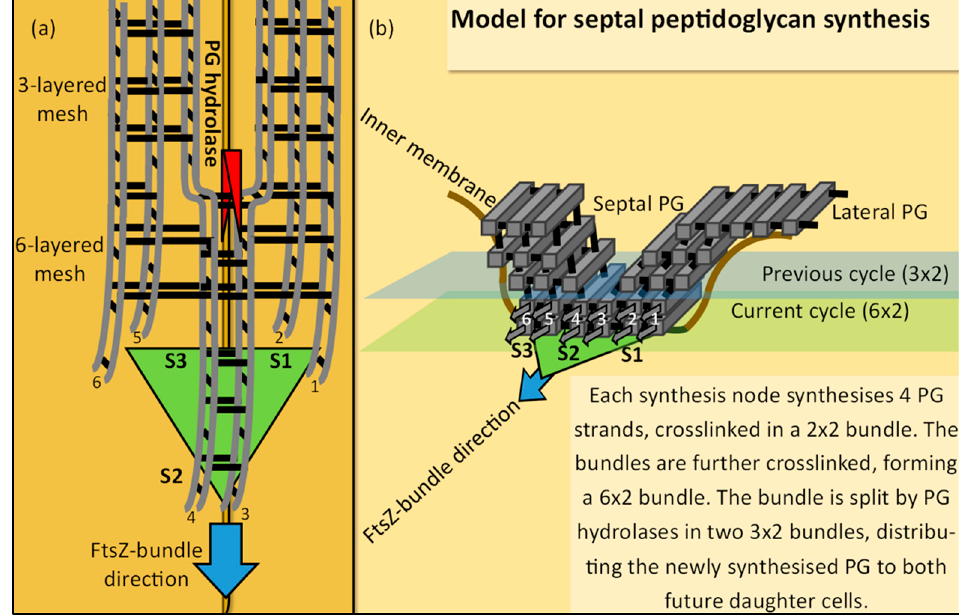
Figure 18. A speculative model describing peptidoglycan synthesis based on the synthesis complex. ( a ) At top-down scheme from the periplasm is shown. Here, the synthesis complex is in green and travels around the division site guided by FtsZ filament bundles (blue arrow). The three synthesis nodes (S1, S2, and S3) each produce a PG bundle consisting of 4 PG strands in a 2 × 2 conformation (grey lines = NAM-NAG polymers; black lines = crosslinked peptides). The numbers (1, 2, 3, 4, 5, and 6) indicate the two PG strands, vertically crosslinked in the model, which are further crosslinked with two PG strands synthesized by the other FtsWI–PBP1b subcomplex localized in the synthesis node. Further crosslinking of the newly synthesized PG bundles leads to a PG mesh of 6 strands wide and 2 strands high (6-layered mesh). The 6-strand-wide PG mesh is speculated to be divided by lagging PG hydrolases in two separate meshes, each 3 strands wide and 2 strands high (3-layered mesh). The two 3 × 2 PG meshes would be divided over two future daughter cells by the outer membrane, which would be in line with the current view concerning the structural conformation of PG at the cell poles. ( b ) We see the same speculative model describing septal peptidoglycan synthesis from a frontal view. Here, sPG synthesis is shown from a frontal perspective. The inner membrane (brown line) and the PG layer (grey blocks = NAM-NAG polymers; black lines = crosslinked peptides) are shown, while the outer membrane is excluded for simplicity. A distinction is made between lateral PG, which is mostly single-layered, while septal PG is three-layered in the model. The synthesis complex (green) produces the 6 × 2 PG mesh, which is not yet separated by PG hydrolases (not shown here) in the current cycle of remodeling. The PG mesh produced in the previous cycle has already been separated in two 3 × 2 meshes, where each mesh is distributed over a future daughter cell. This model, based on the supposed conformation of the synthesis complex, provides a cycle-based mechanism, where during each cycle a new PG mesh is produced inward from the PG produced during the previous cycle (or from a lateral, single-layered PG). The separation by PG hydrolases during the previous cycle may lead to denuded glycans, which can be bound by FtsN, providing a platform for the synthesis complex to produce new PG in an inward